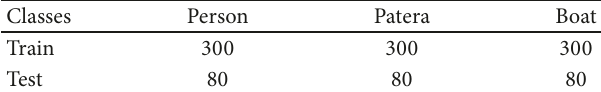
Table 6: Balanced training and test